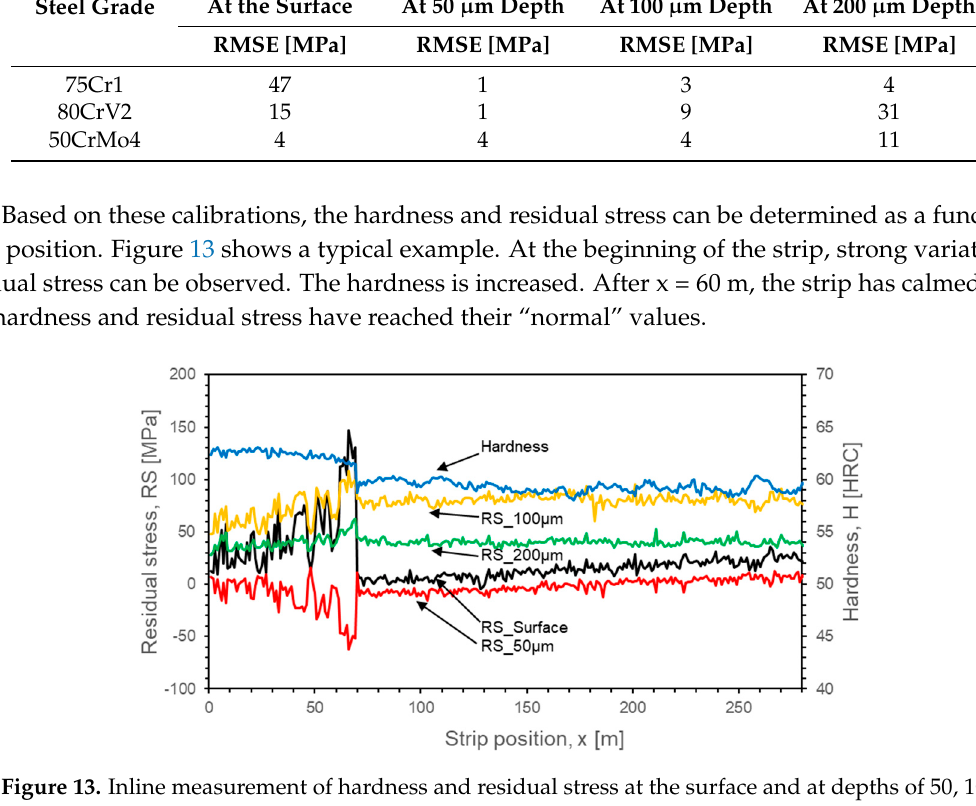
Figure 13. Inline measurement of hardness and residual stress at the surface and at depths of 50, 100, and 200 μ m.